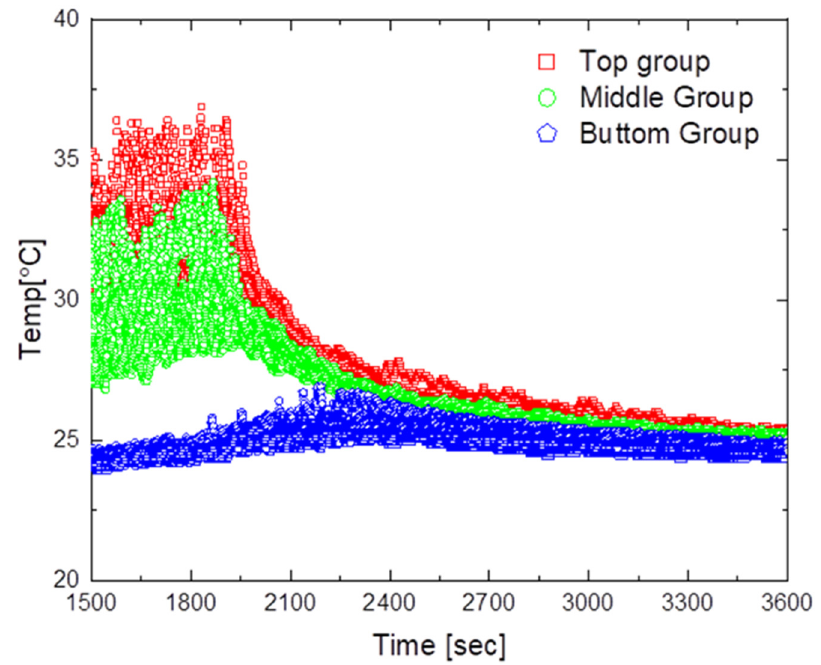
Figure 14. Temperature distribution for the optimized air circulator operating at 2 m/s.